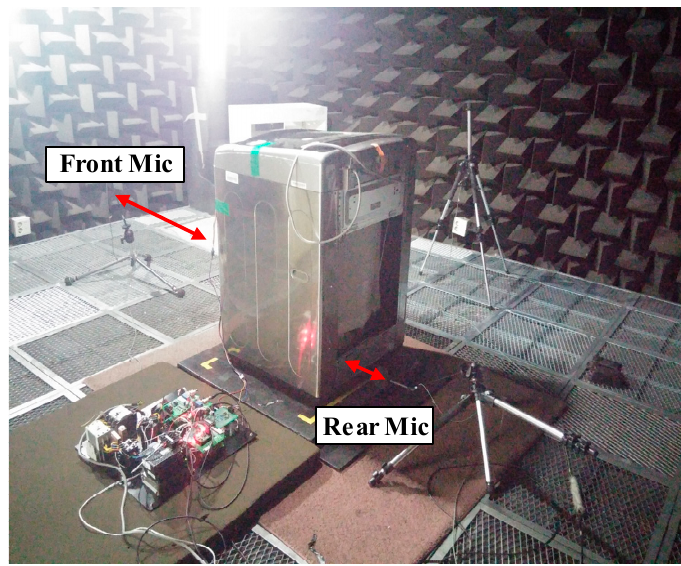
Figure 20. Anechoic chamber provided by LG Electronics. Energies 2019 , 12 , x FOR PEER REVIEW